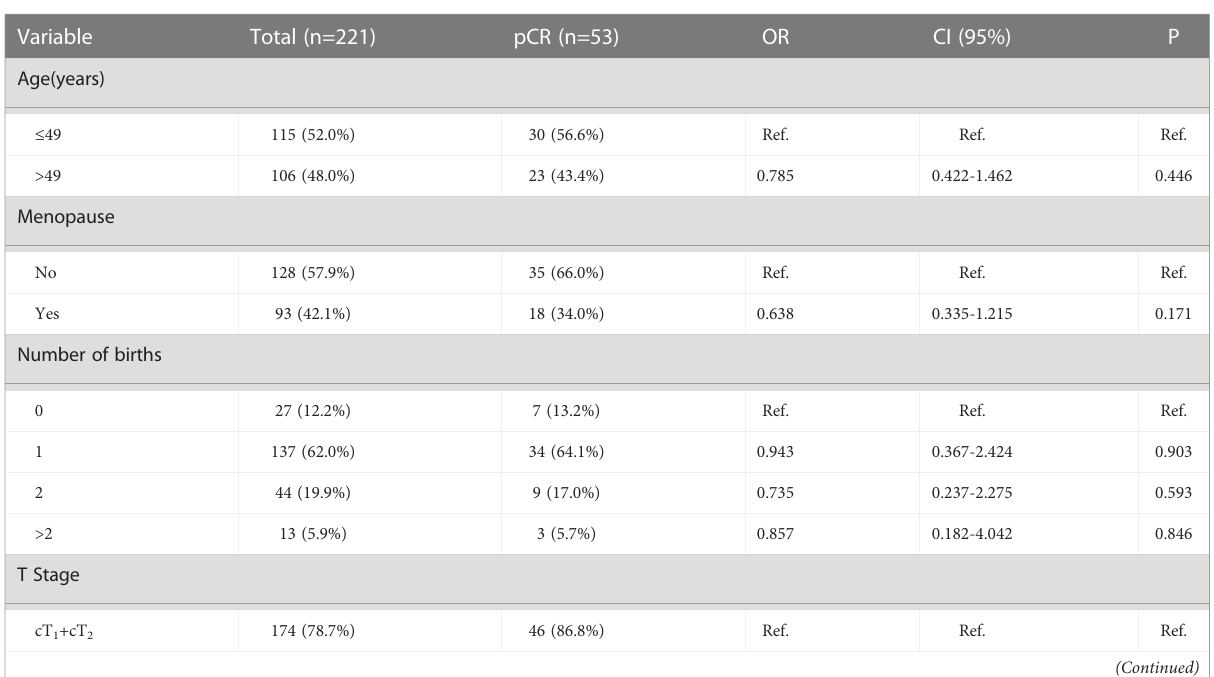
TABLE 2 Univariate analysis between clinical characteristics and